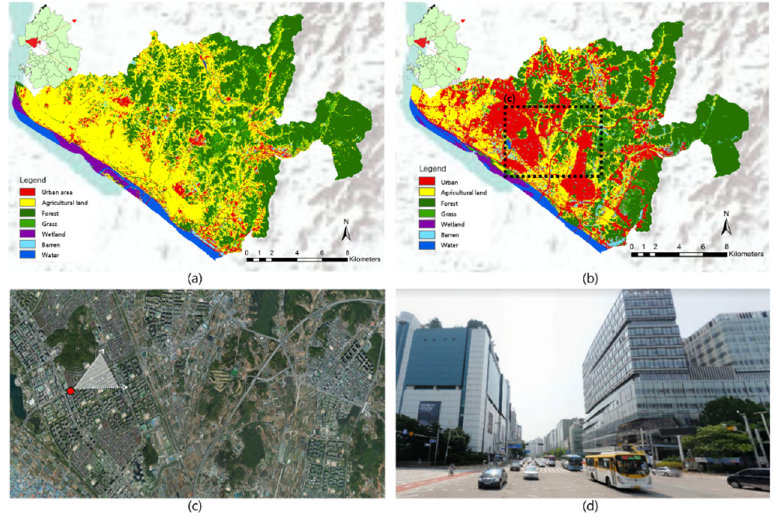
Figure 8. ( a ) 1988 land cover map of Goyang, ( b ) 2018 land cover map of Goyang, ( c ) satellite image of map (b) and ( d ) road view of map ( c ) Most of the space that used to be agricultural land has been converted into urbanization areas.